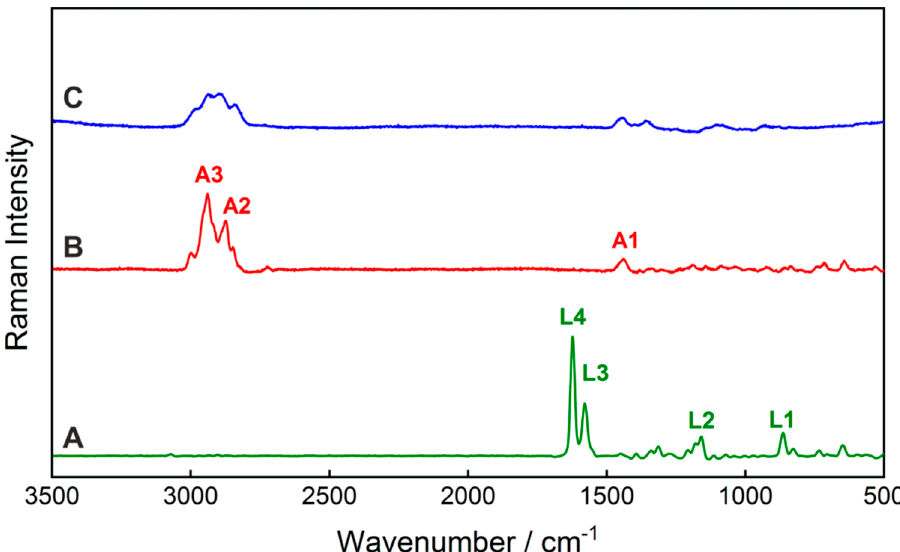
Figure 1. Raman spectra of the active pharmaceutical ingredients lumefantrine ( A ) and artemether ( B ), as well as the excipient hypromellose ( C ), with an excitation wavelength of λ = 532 nm. The spectra of artemether and hypromellose were scaled with a factor of five for better visibility. The band assignment of the prominent Raman bands A1–A3 and L1–L4 and their spectral positions are listed in Table 1.